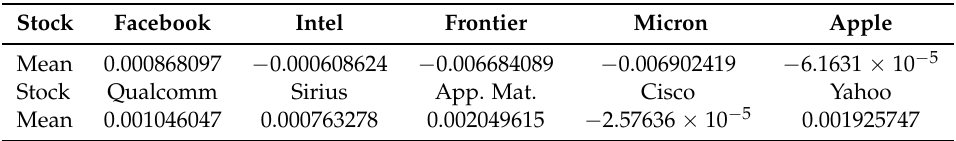
Table 1. Expected returns.